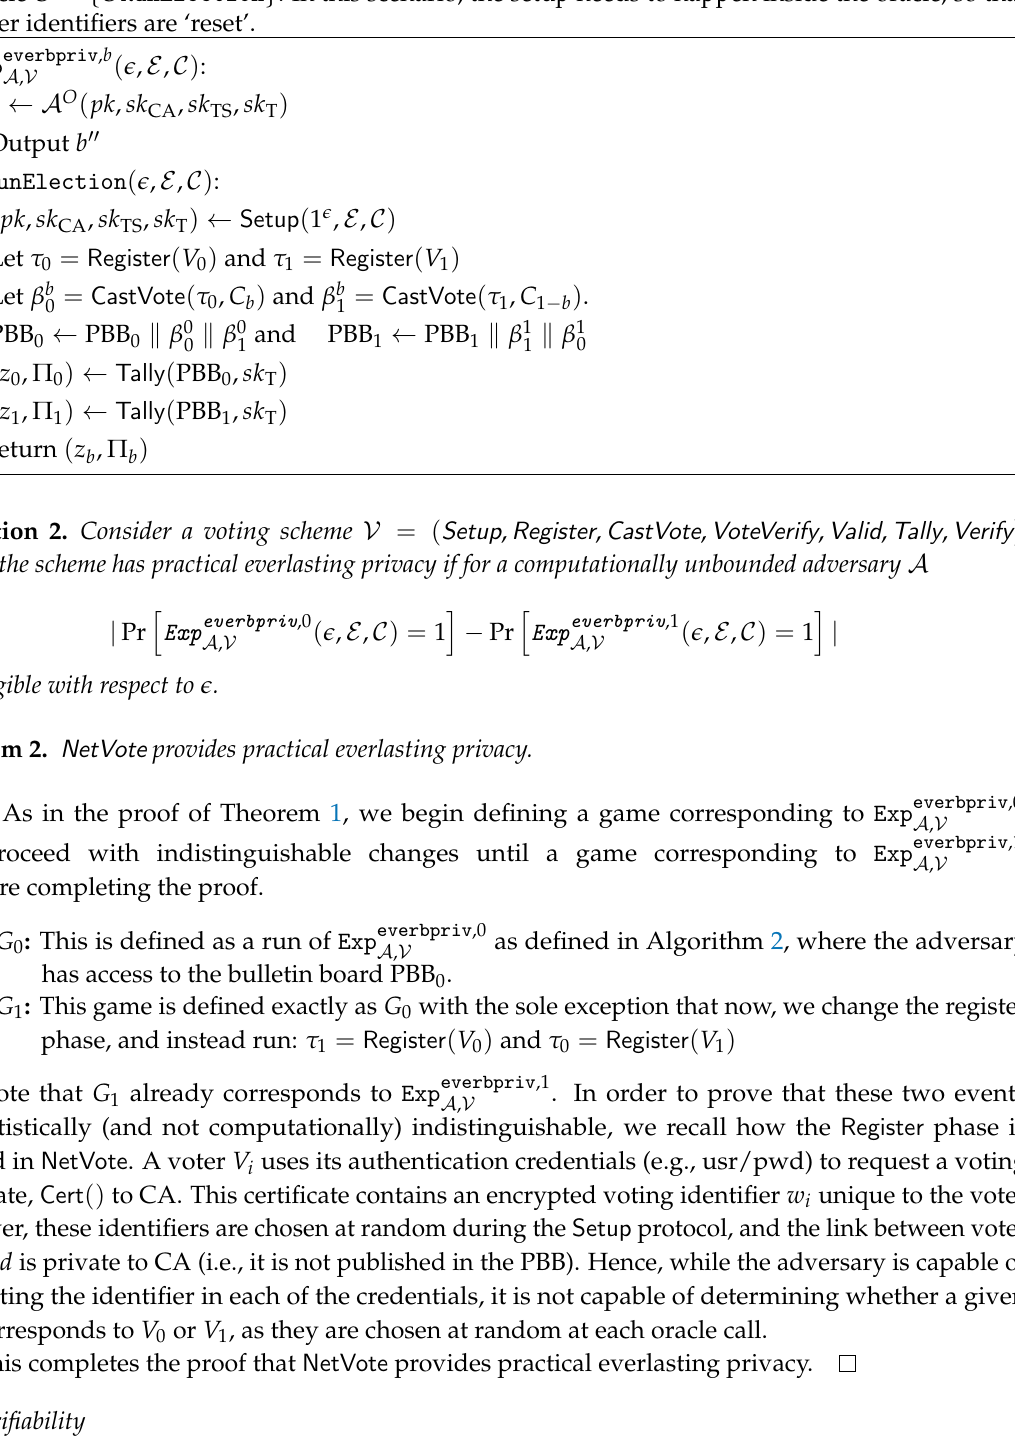
everbpriv , b () , the adversary A has access to A , V